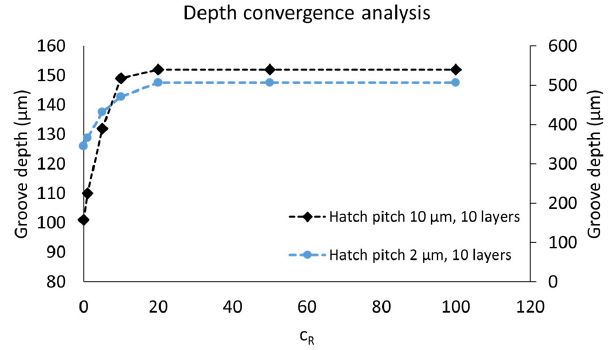
Figure 12. Depth convergence analysis for grooves obtained with 10 layers with hatch pitches of 2 μ m (primary vertical axis) and 10 μ m (secondary vertical axis). 2 µ m (primary vertical axis) and 10 µ m (secondary vertical axis).